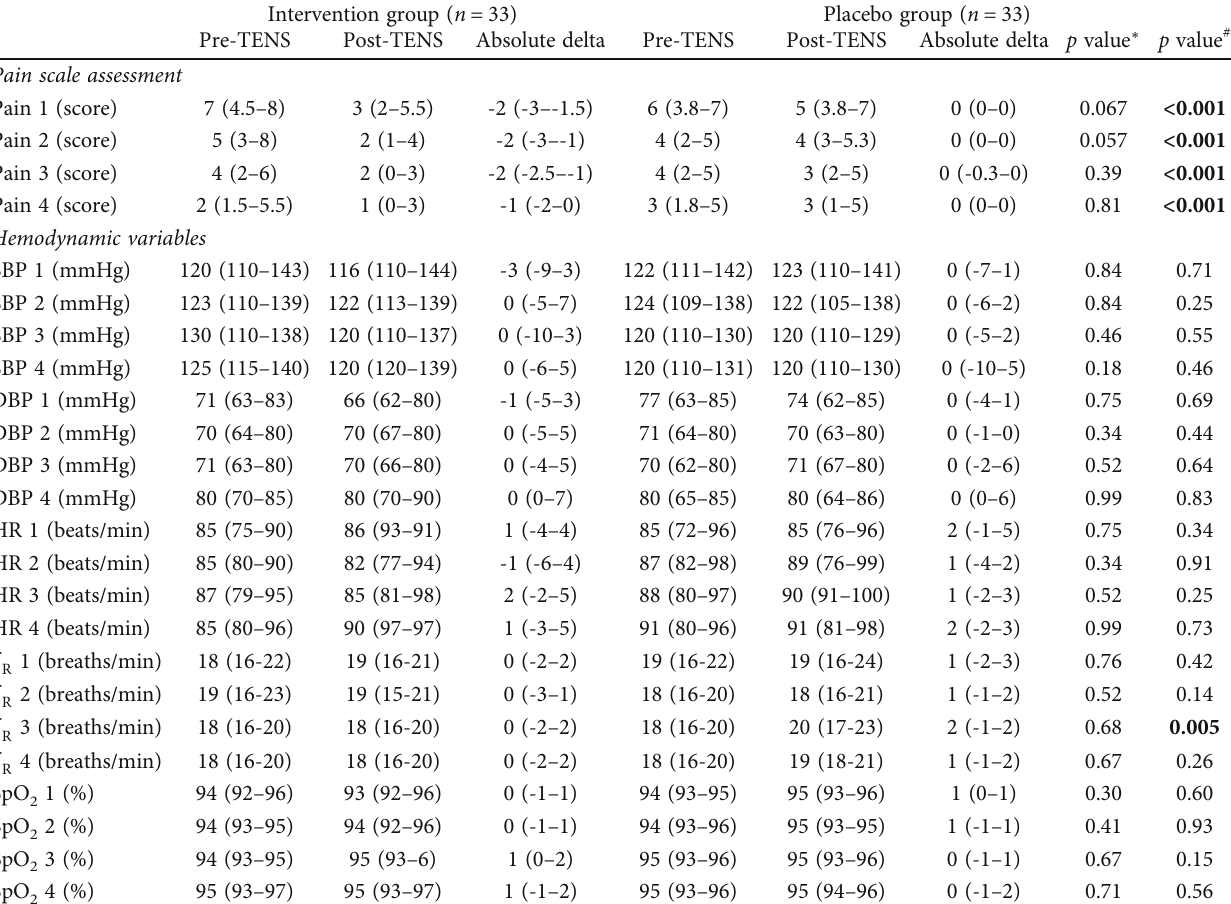
Table 3: Pain scale scores and haemodynamic data before and after the application of TENS and placebo.